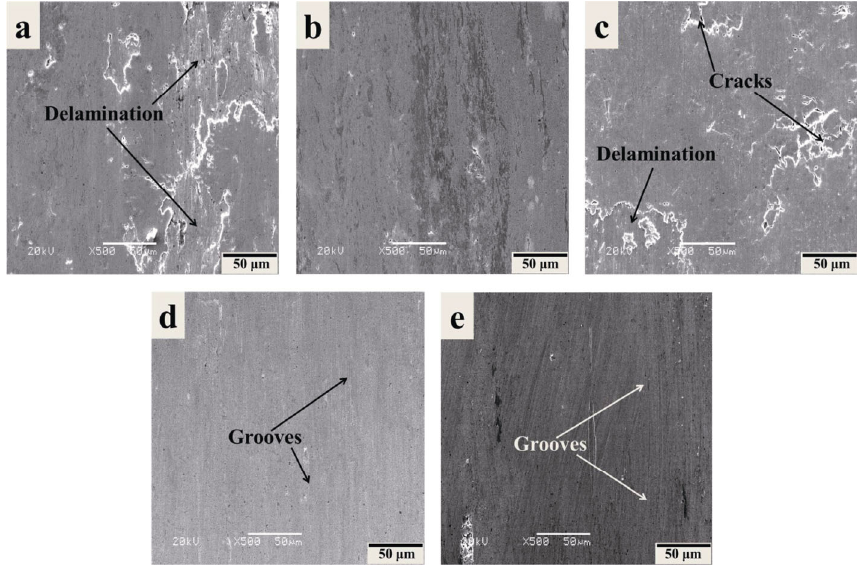
Fig. 9 SEM images of the worn surfaces of composite G2: (a) 25 ºC, (b) 200 ºC, (c) 400 ºC, (d) 600 ºC, and (e) 800